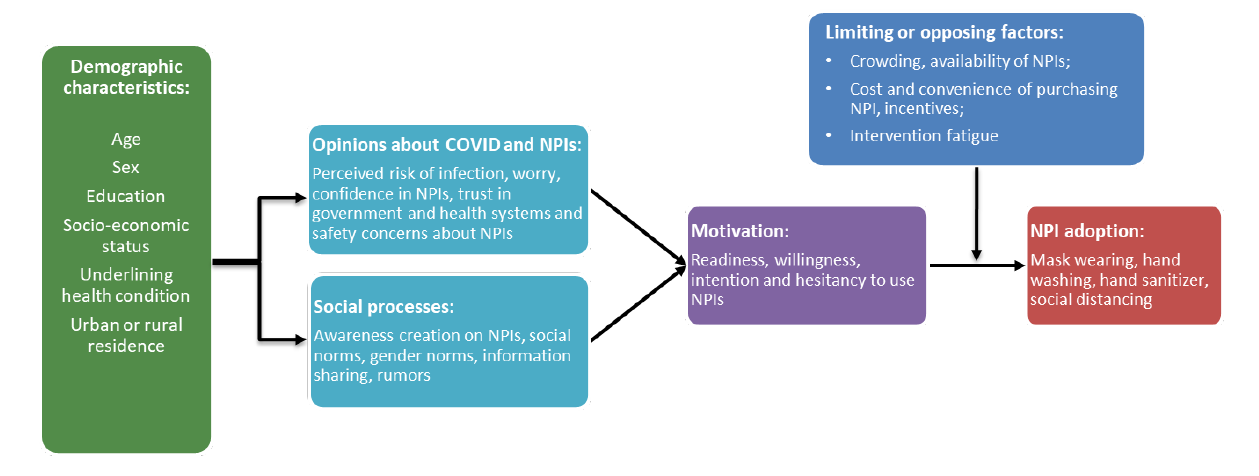
Figure 1. Theoretical framework: The COVID-19 prevention NPIs.